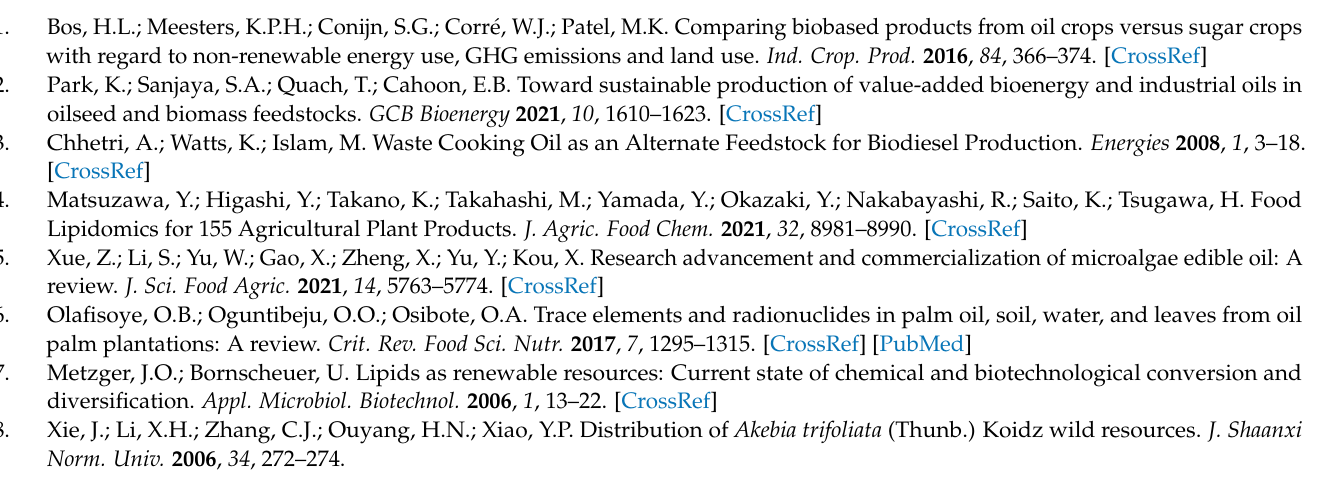
new genes annotated in the database. Table S4: Differentially expressed genes. Figure S1: Expression patterns of three modules. (A) The tan module. (B) The dark orange module. (C) The turquoise module. Figure S2: GO and KEGG pathways of DEGs. A. GO pathways of DEGs for the three modules; B. KEGG pathways of DEGs for the three modules; C. GO pathways of DEGs for U in comparison with I; D. KEGG pathways of DEGs for U in comparison with